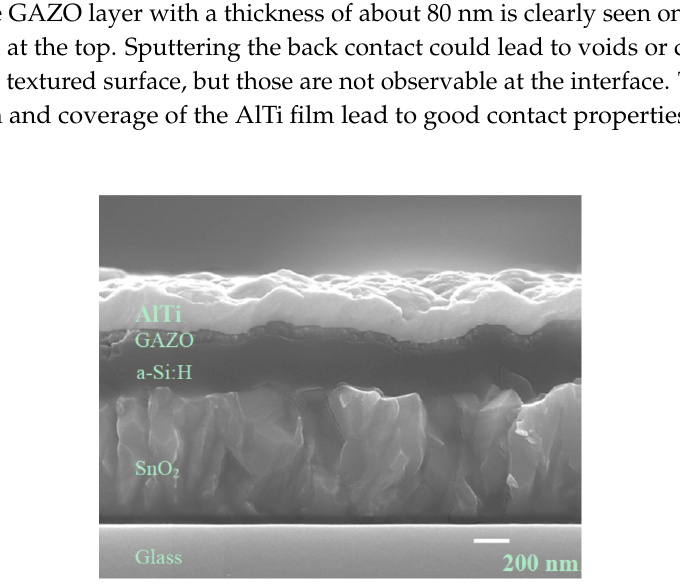
Figure 6. Cross-section scanning electron microscopy (SEM) image of p-i-n silicon thin-film solar cell with AlTi back contact.